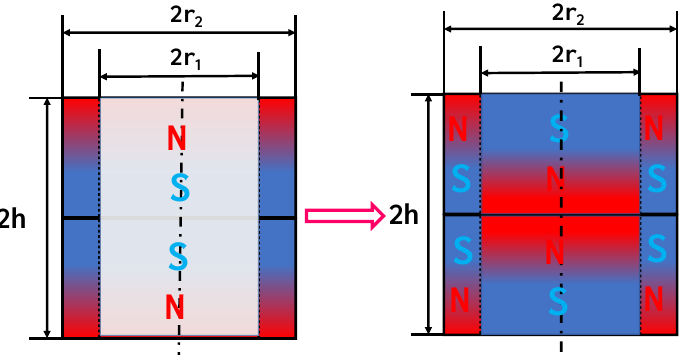
Figure 5. Magnetic ring equivalent diagram.